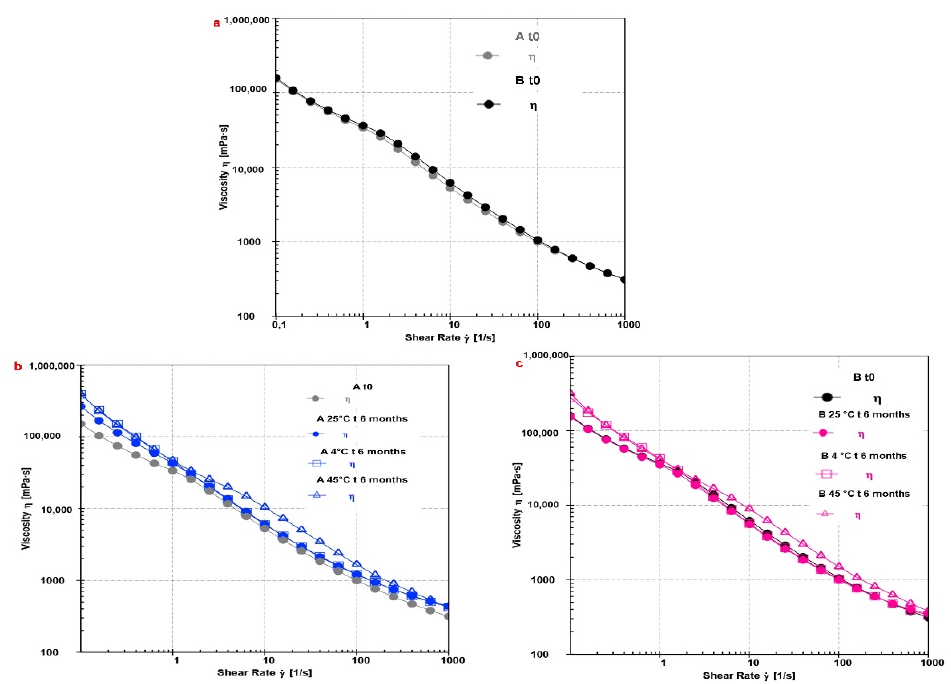
Figure 4. Flow curves obtained from viscosity (η) as a function of shear rate (Ύ), for the different